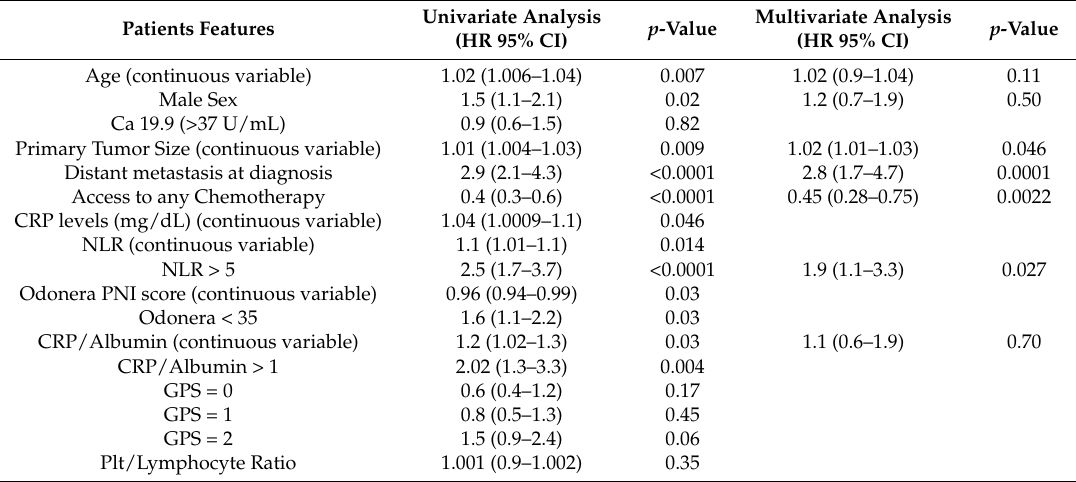
Table 2. Factors associated with overall survival (OS) at univariate and multivariate regression analysis.